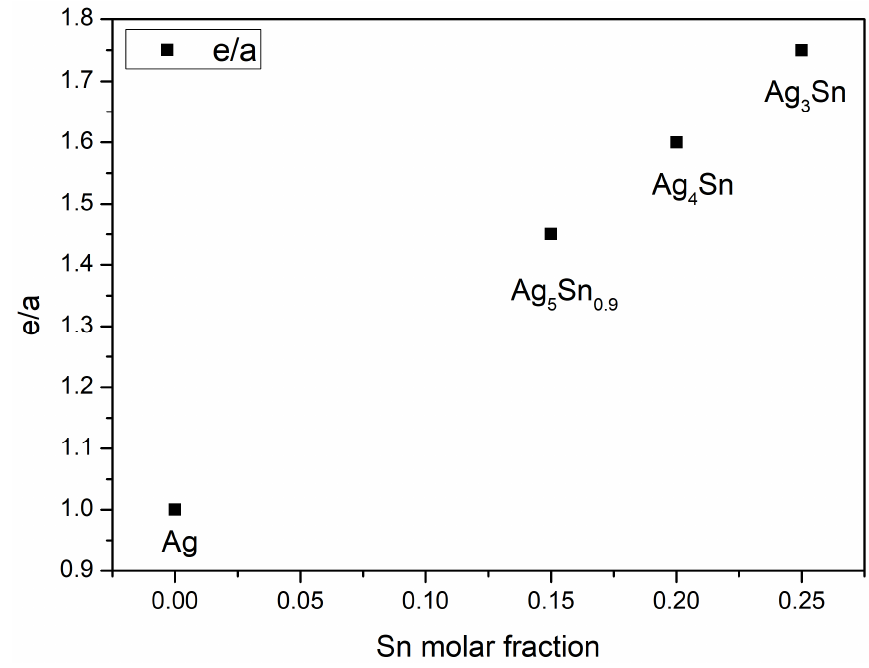
Figure 7. Evolution of electron concentration (e/a) as function of tin molar fraction .